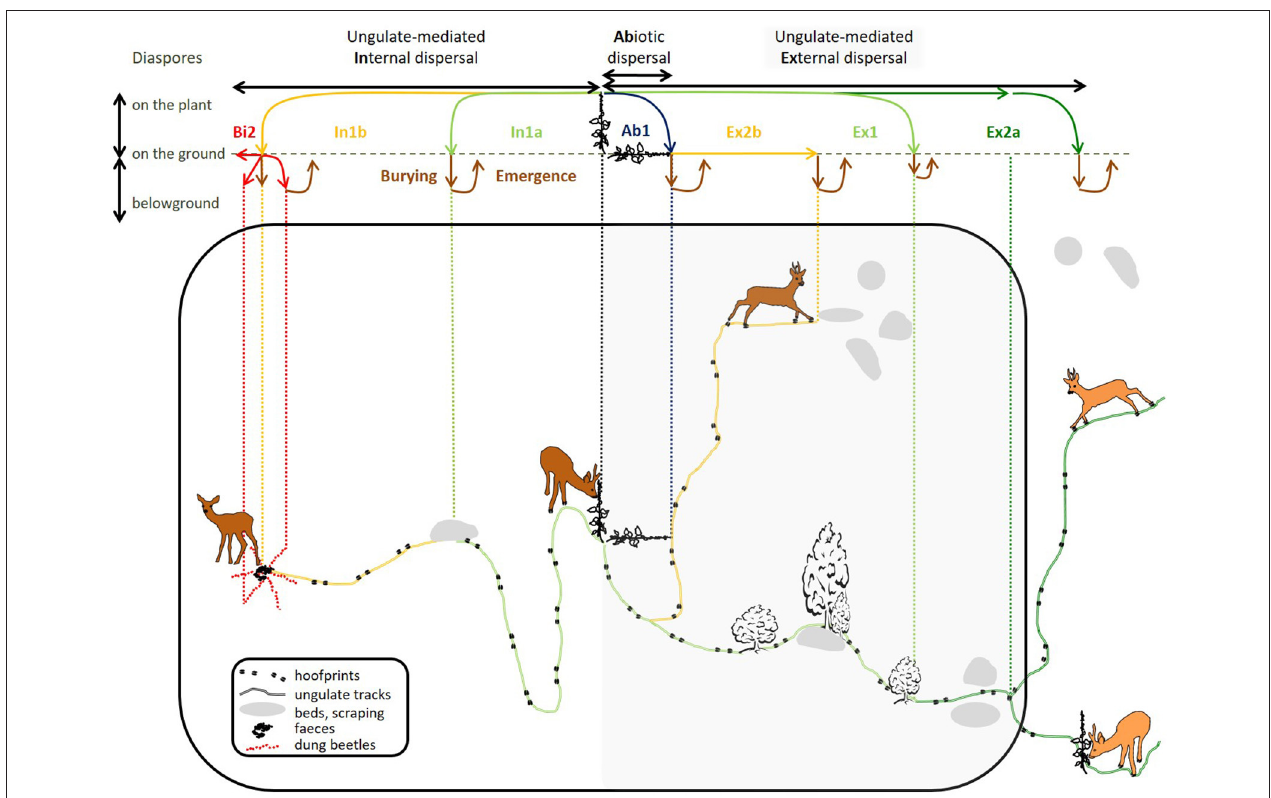
FIGURE 1 | General spatial representation of primary internal ungulate-mediated plant dispersal mechanisms (indicated by 1: In1a regurgitation, In1b endozoochory) and primary ( Ex1 fur-epizoochory) and secondary external ungulate-mediated plant dispersal mechanisms (indicated by 2: Ex2a transfer-epizoochory, Ex2b hoof-epizoochory) and the associated horizontal and vertical trajectories of the carried diaspores. To the left side of the parent plant, the diagram describes internal mechanisms; the shaded part to the right represents external mechanisms. Ab iotic dispersal by gravity ( Ab1 barochory) can be considered as a first step of dispersal. And secondary dispersal by other bi otic vectors like coprophagous beetles ( Bi2 ) is considered as a second step following endozoochory ( In1b ). The top part of the diagram shows the fate of a diaspore for each dispersal mechanism from the parent plant to its final destination (moving from the diaspore regional pool to the transferred pool, the soil surface pool and finally, the soil seed bank, Box 1 ). The large black rectangular shape delimits the home range of the